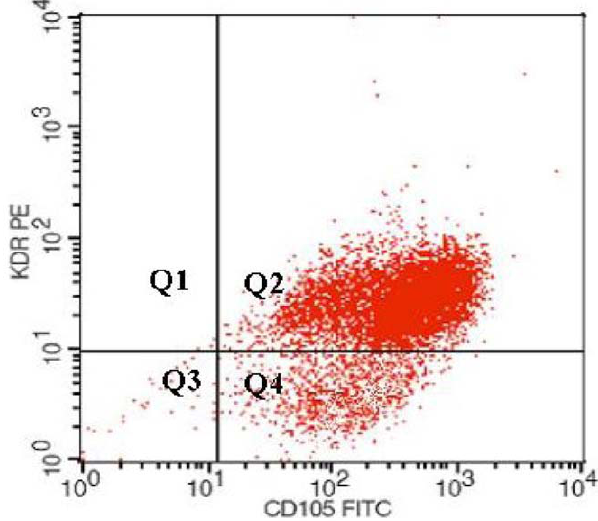
Figure 1. HEEC characterization. Endometrial samples were subjected to CD31 and CD105 cell immunomagnetic isolation by incubation with anti-CD31 and anti-CD105 conjugated-microbeads, and subsequent loading on a MidiMACS device. Cell viability after immunoselection exceeded 98% in all cases, as judged by propidium iodide staining by flow cytometry. Cells recovered were analyzed for the presence of endothelial markers (Vascular Endothelial Growth Factor Receptor-2 or KDR and CD 105) by flow cytometry analysis (KDR-PE/ CD105-FITC=97%).